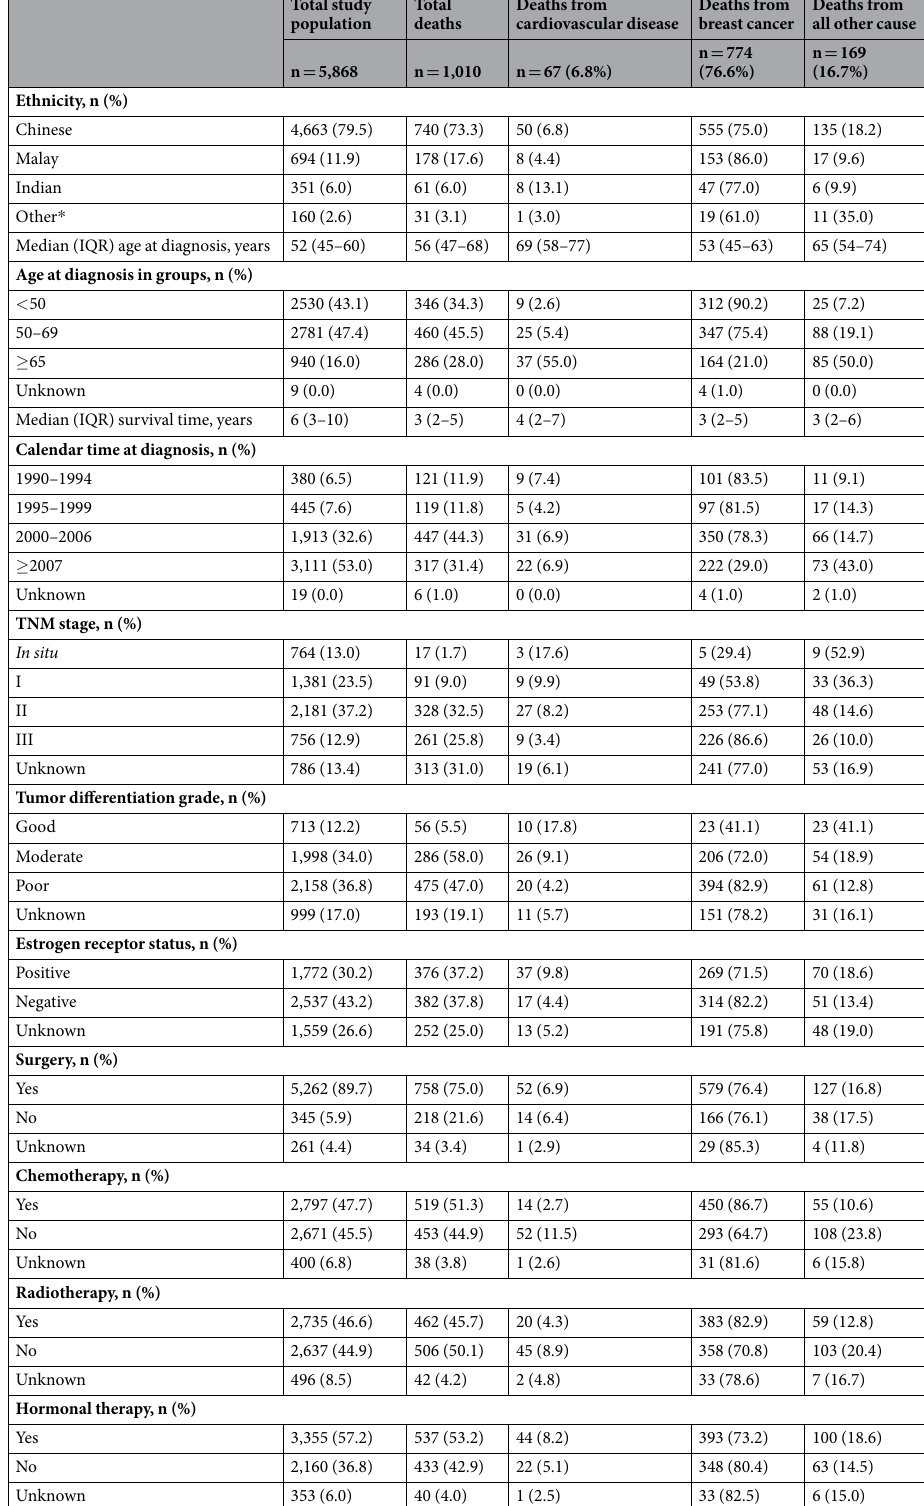
Table 1. Characteristics of the total study population and by death from cardiovascular disease, breast cancer, and all other cause, within 10 years of diagnosis in Southeast Asian women with breast cancer. Abbreviations: IQR, Interquartile range; TNM, Classification of Malignant Tumors. * Includes e.g. Sikh, Eurasian and Caucasian. Column percentages presented for total study population and total deaths; Row percentages (percentages of total deaths) presented for deaths from cardiovascular disease, deaths from breast cancer, and deaths from all other